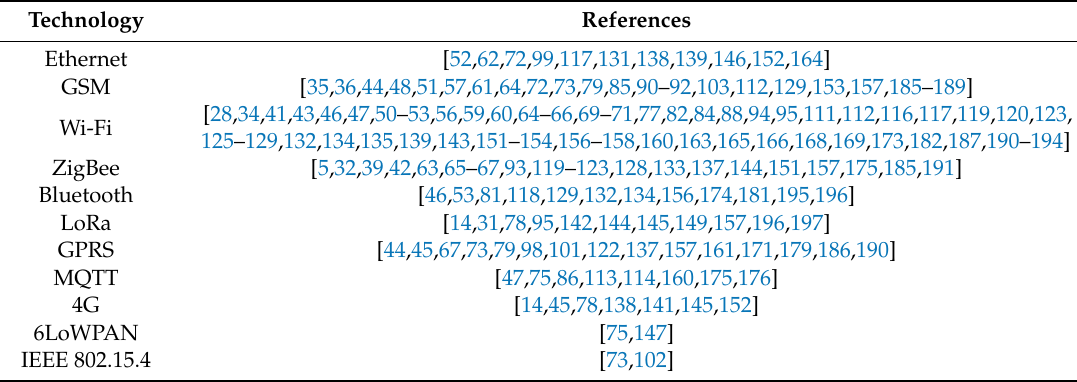
Table 6. Most utilized communication technologies in IoT crop irrigation